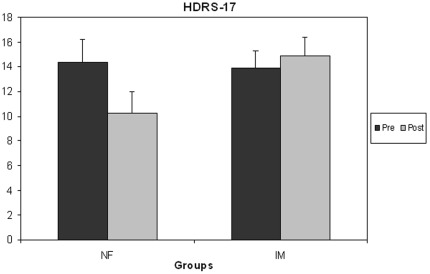
Neurofeedback produced clinical improvement that was not seen in the control group.Patients in the neurofeedback (NF) treatment group, but not those in the imagery (IM) control group, improved significantly on the 17-item Hamilton Depression Rating scale, a standard clinical measure of depression severity and treatment effects. Lower values denote clinical improvement (error bars: standard errors).